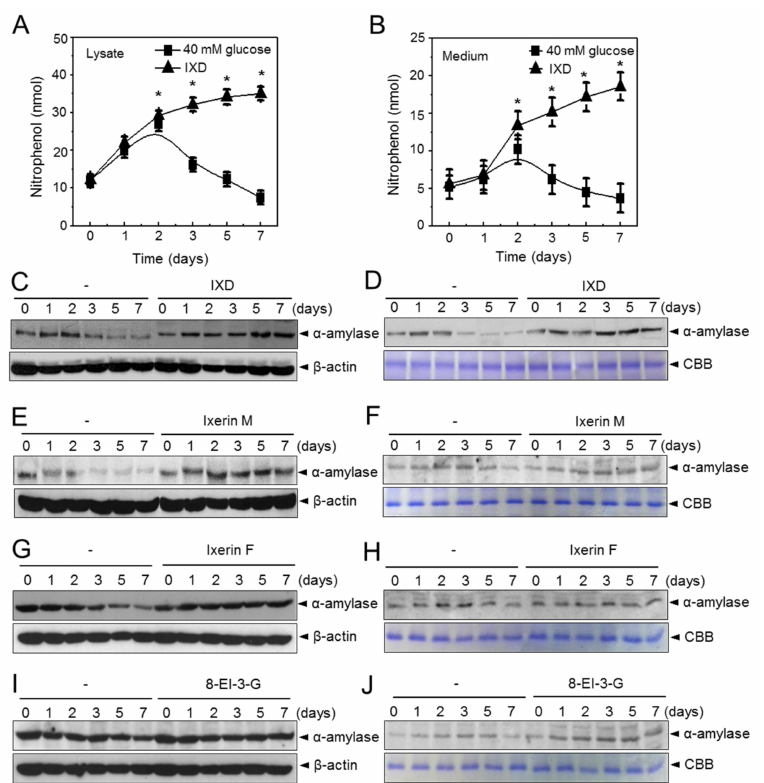
Figure 2. The IXD extract increases amylase synthesis and secretion in human salivary gland cells exposed to high glucose levels. ( A , B ) Amylase activity was measured in cell lysates ( A ) and cultured medium ( B ) of HSG cells exposed to high glucose concentrations with or without the IXD extract for 1, 2, 3, 5, and 7 days. Values are represented as mean ± SEM ( n = 3, p < 0.05). * indicates significant differences with the IXD-untreated cell condition; ( C , D ) amylase expression in cell lines exposed to high glucose concentrations treated with or without the IXD extract for the indicated time period; ( C ) amylase protein expression was analysed using cell lysates; ( D ) amylase protein expression was analysed using cell cultured medium; ( E , F ) HSG cells were exposed to high glucose concentrations (40 mM) for 1, 2, 3, 5, and 7 days in the presence or absence of Ixerin M, a purified IXD component, and amylase expression was measured in cell lysates ( E ) and cell medium ( F ); ( G , H ) amylase protein expression was analysed in cell lysates or cultured medium in the presence or absence of Ixerin F and ( I , J ) epiisolipidiol-3- β - D -glucopyranoside